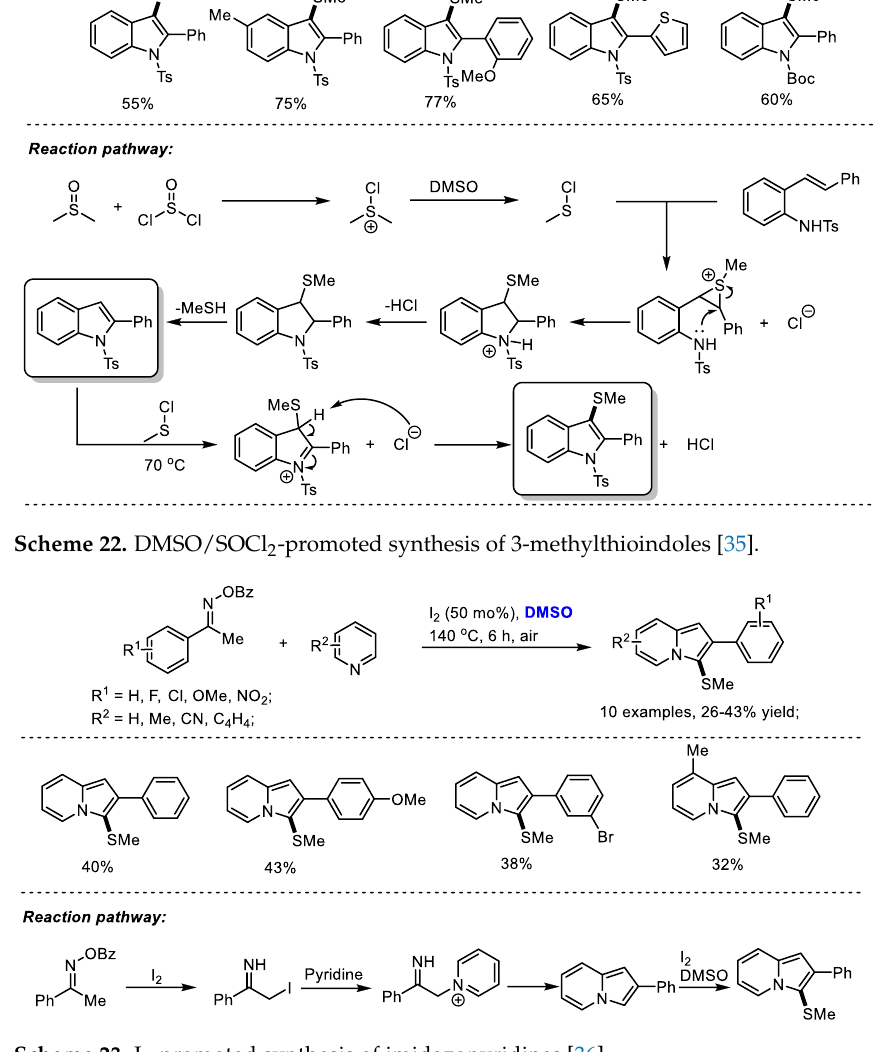
Scheme 23. I 2 -promoted synthesis of imidazopyridines